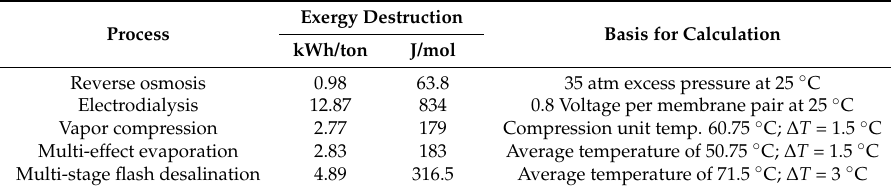
Table 2. Exergy destruction in a desalination process